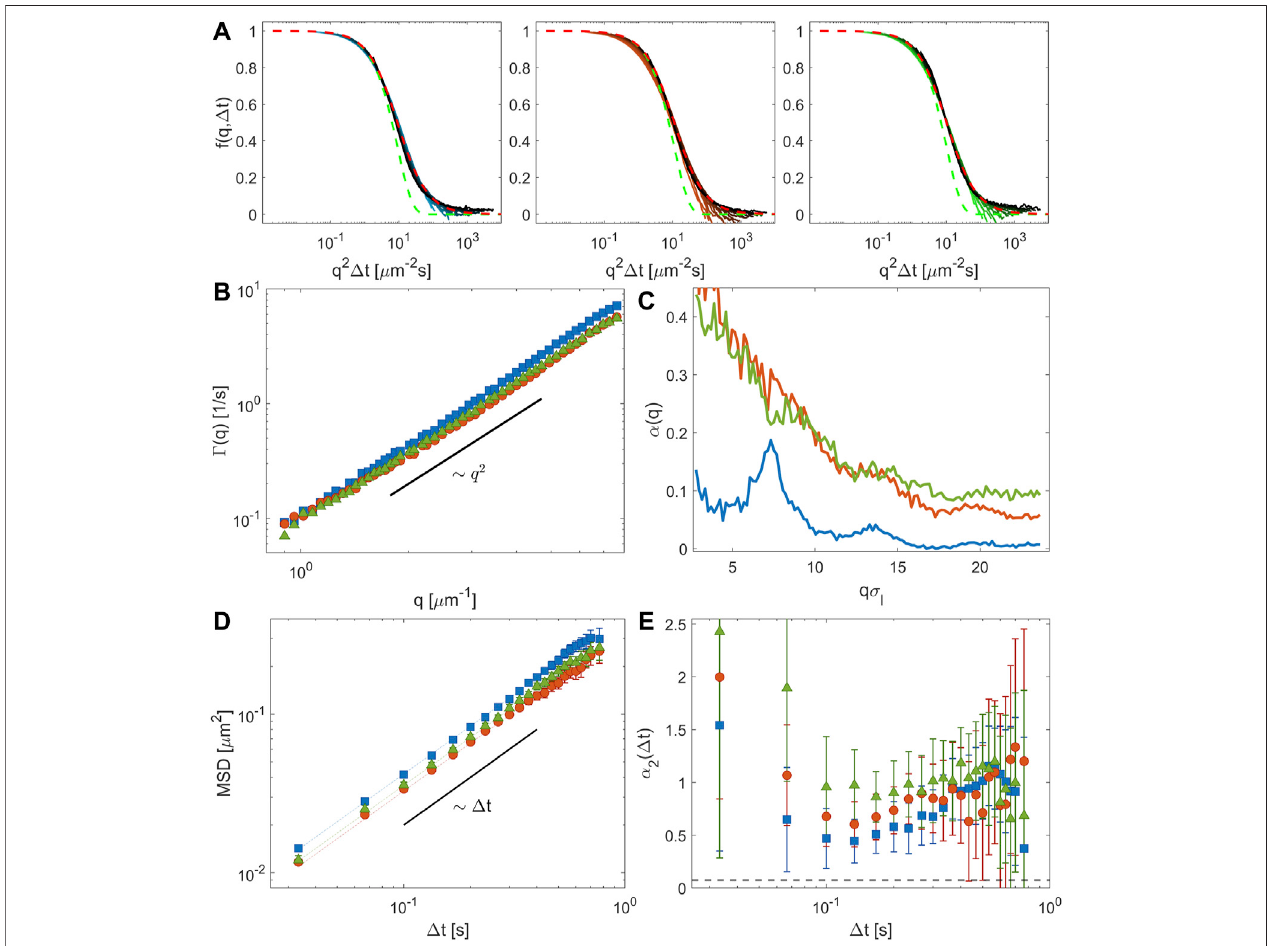
FIGURE4| Changes in the dynamics of thesmall particles upon increasing the volume fraction of the glassy matrix from ϕ = 0.60 (blue), to ϕ = 0.61 (red), and ϕ = 0.62 (green). (A) Representative self-ISFs plotted as a function of the rescaled time q 2 Δ t . The red dashed lines represent the model f (cid:2) [ 1 + D ϕ , Δ t ] − 1 , self a q 2 whereas the green dashed lines correspond to f self (cid:2) e − D ϕ , a q 2 Δ t . For each concentration, D ϕ ,a is estimated from a quadratic fi t to the q -dependent relaxation rates – 2 μ m 2 /s, D – 2 μ m 2 /s and D – 2 μ m 2 /s). Γ ( q ) obtained by fi tting the model given in Eqs 5 , 8 to the ISF ( D 60,a = (11 ± 1) × 10 61,a = (9.0 ± 0.8) × 10 62,a = (9.8 ± 0.5) × 10 (B) Relaxation rate for the three different concentrations obtained by fi tting the model in Eqs 5 , 8 to the ISF, as explained in Section 3.2 . (C) Non-ergodicity factor α ( q ). (D) MSD and (E) the non-Gaussian parameter α Δ t ) estimated using the model-free procedure (see Methods ). The dotted lines are the best fi tting curves to 2 ( the MSDs with a linear model MSD ( Δ t ) = 4 D ϕ ,b Δ t , with D 60,b = (10.5 ± 0.5) × 10 – 2 μ m 2 /s, D 61,b = (8.2 ± 0.4) × 10 – 2 μ m 2 /s and D 62,b = (8.9 ± 0.4) × 10 – 2 μ m 2 /s. The black dashed line in (E) shows the mean value α 2 estimated for the diluted